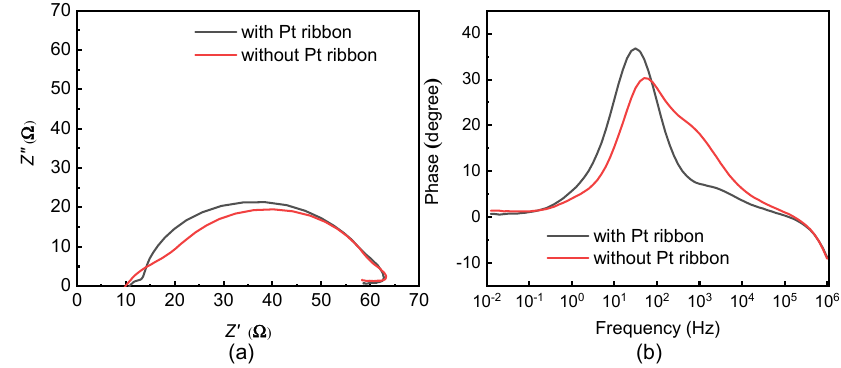
Figure 8. ( a ) Nyquist and ( b ) Bode plots of DSSCs with and without a Pt ribbon. The series resistances ( R s , R ct and R rec ), peak frequencies ( f p ) of the Bode plots and electron lifetimes ( τ ) for the DSSCs with and without a Pt ribbon are presented in Table 2. R s refers to the series resistance related to the electron transport at the FTO/photoelectrode interface; R ct represents the series resistance related to the electron transport at the elec- trolyte/counter electrode interface and R rec refers to the series resistance related to the electron transport at the photoelectrode/electrolyte interface. f p is the peak frequency of the second semi-circle of a DSSC from the Bode plot. τ is given by τ = 1/(2 π × f p ).